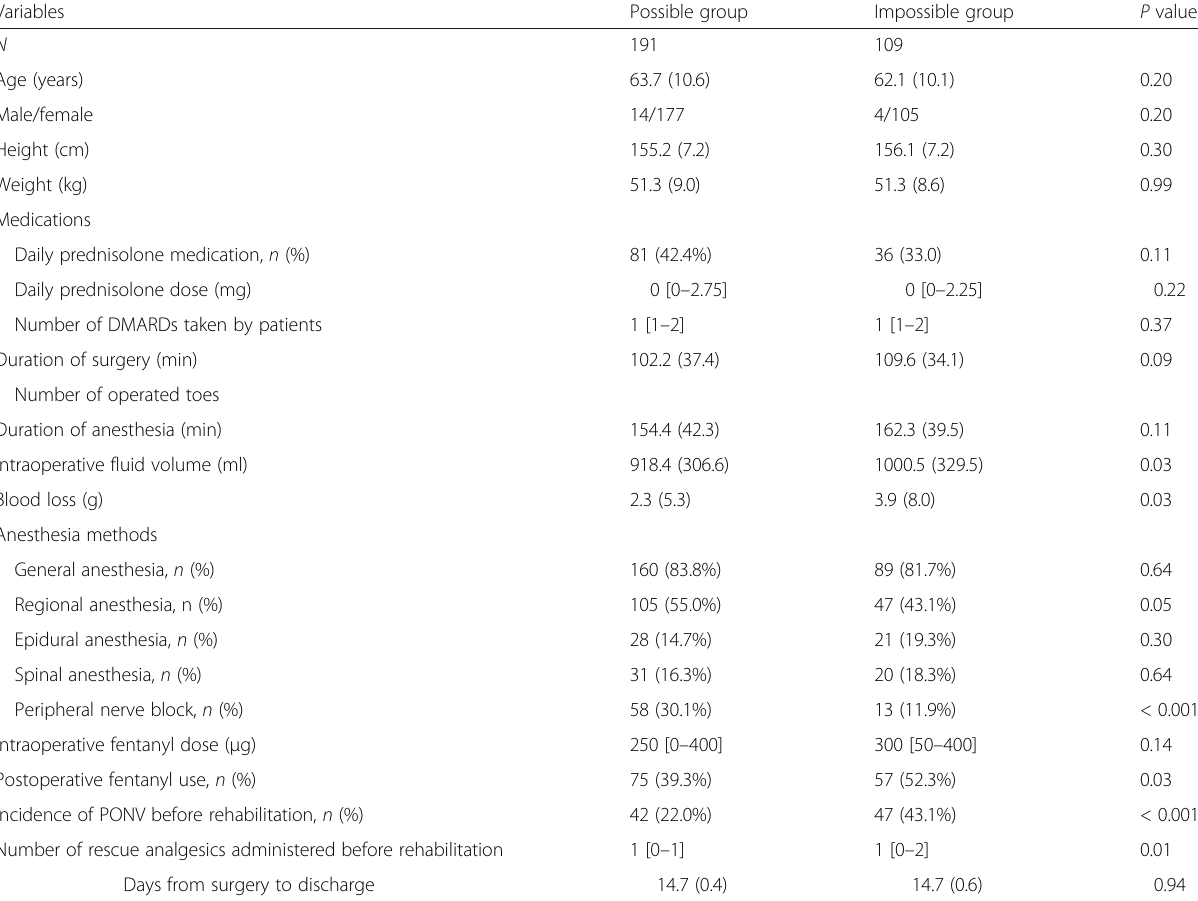
Table 1 Patients ’ demographic and perioperative